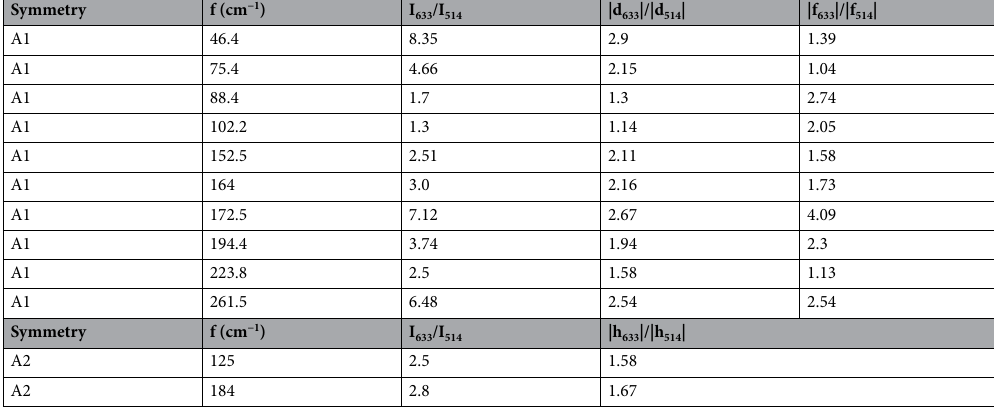
Table 2. Enhancements factors (|d 633 |/|d 514 | and |f 633 |/|f 514 |) for Raman tensor elements |d|, |f| and |h| as determined from